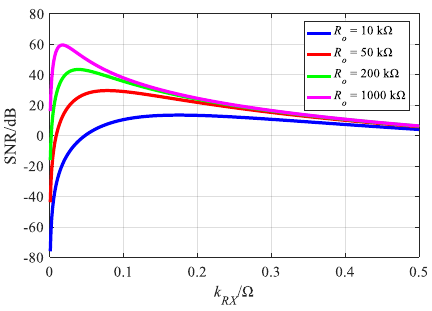
Figure 10. SNR versus k RX with di ff erent R o .